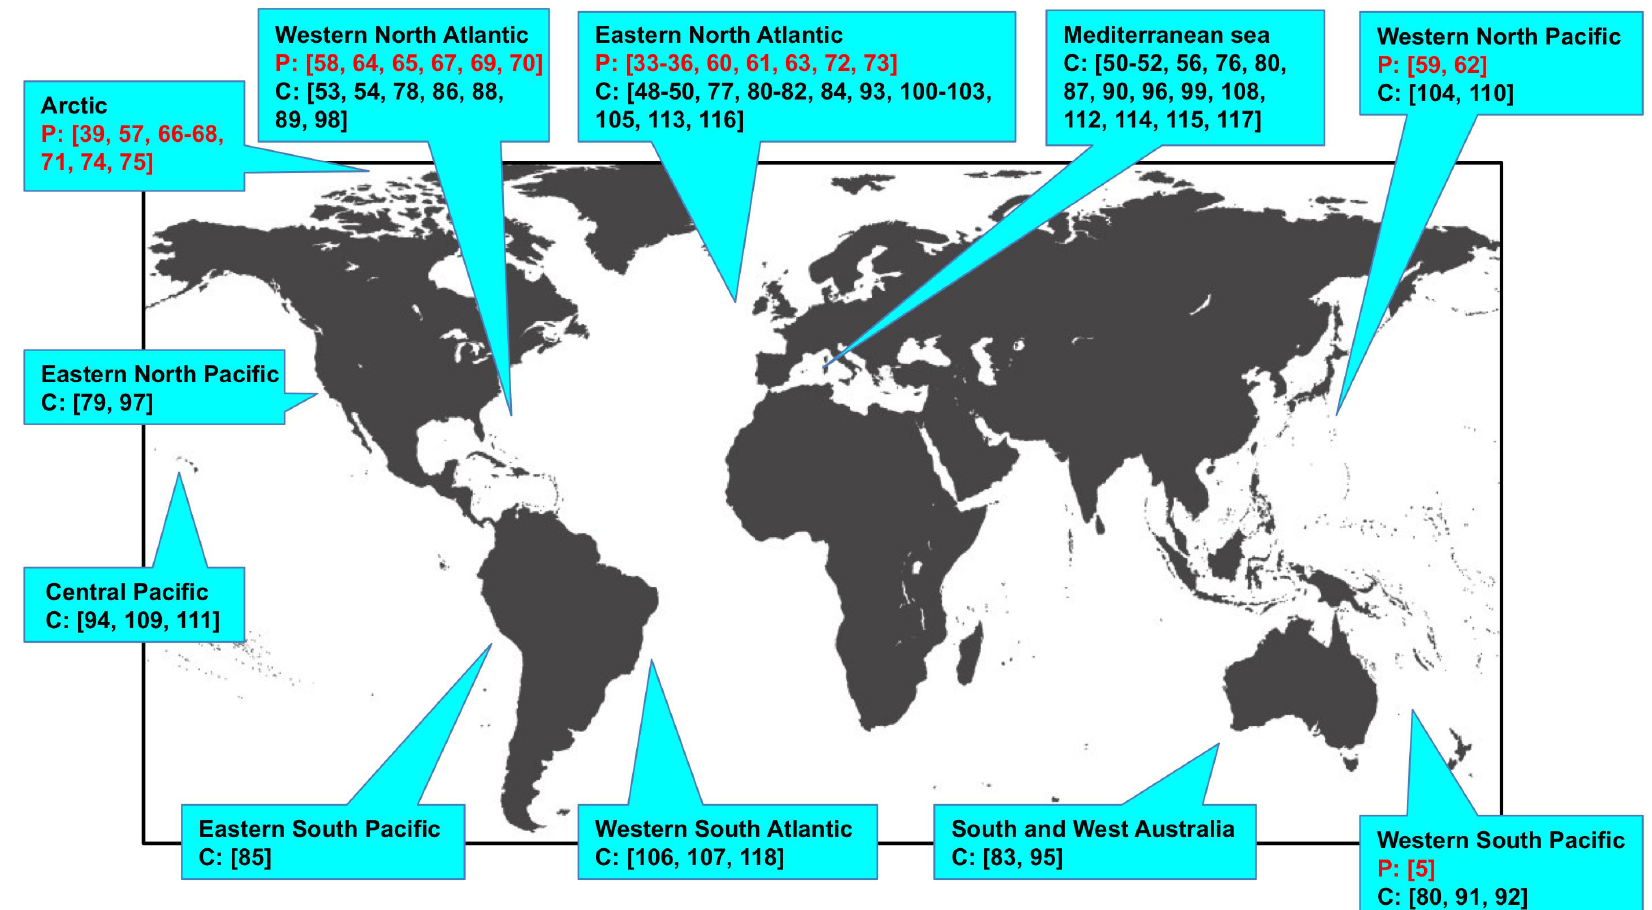
Figure 1. Locations of reported phocine distemper virus infections of pinnipeds and cetacean morbillivirus infections of cetaceans. Numbers indicate references. P (red), pinnipeds; C (black),